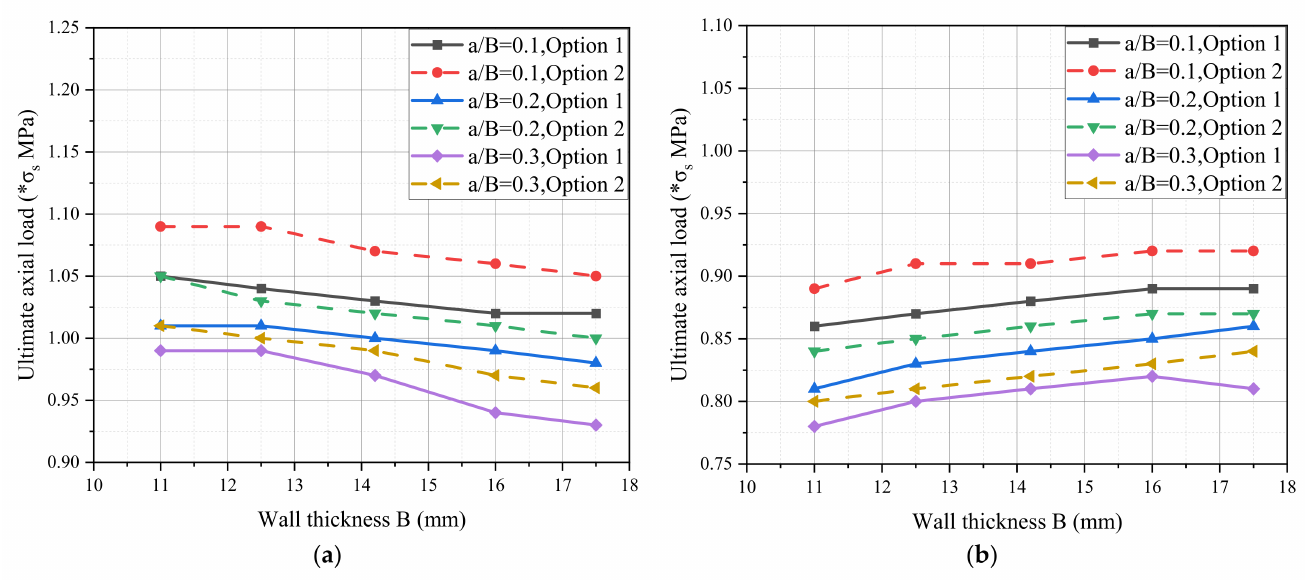
Figure 11. Ultimate axial load of girth weld cracks in pipes with different wall thickness values (2 c/ π D = 0.01). ( a ) e = 0 mm; ( b ) e = 1